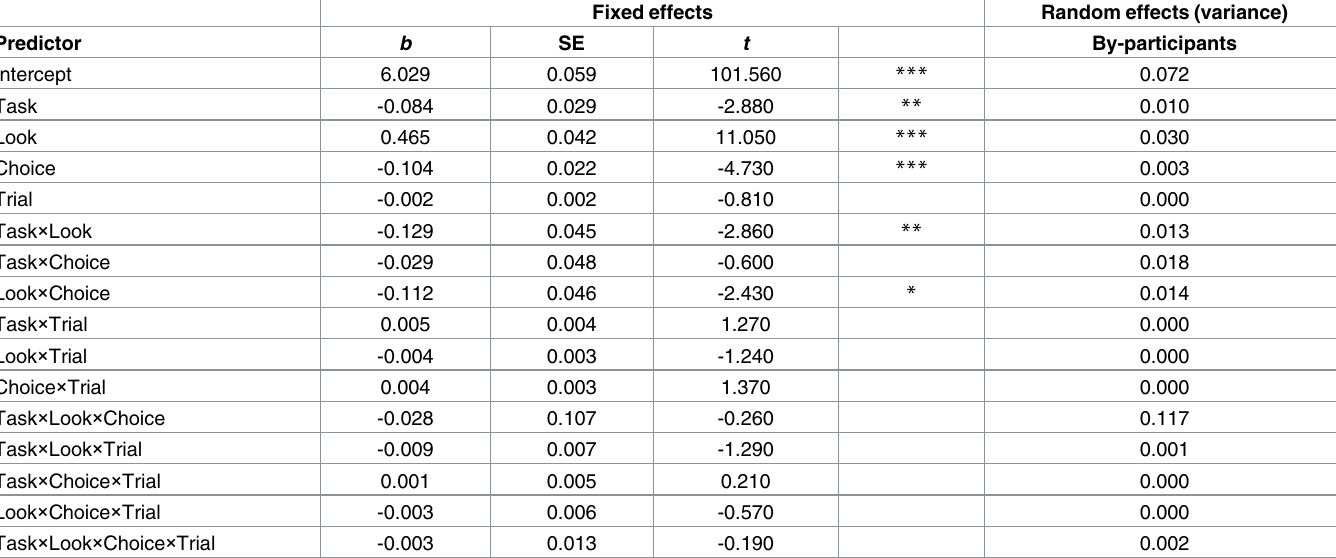
Table 1. Generalized linear mixed models fitting the first dwell time in Experiment